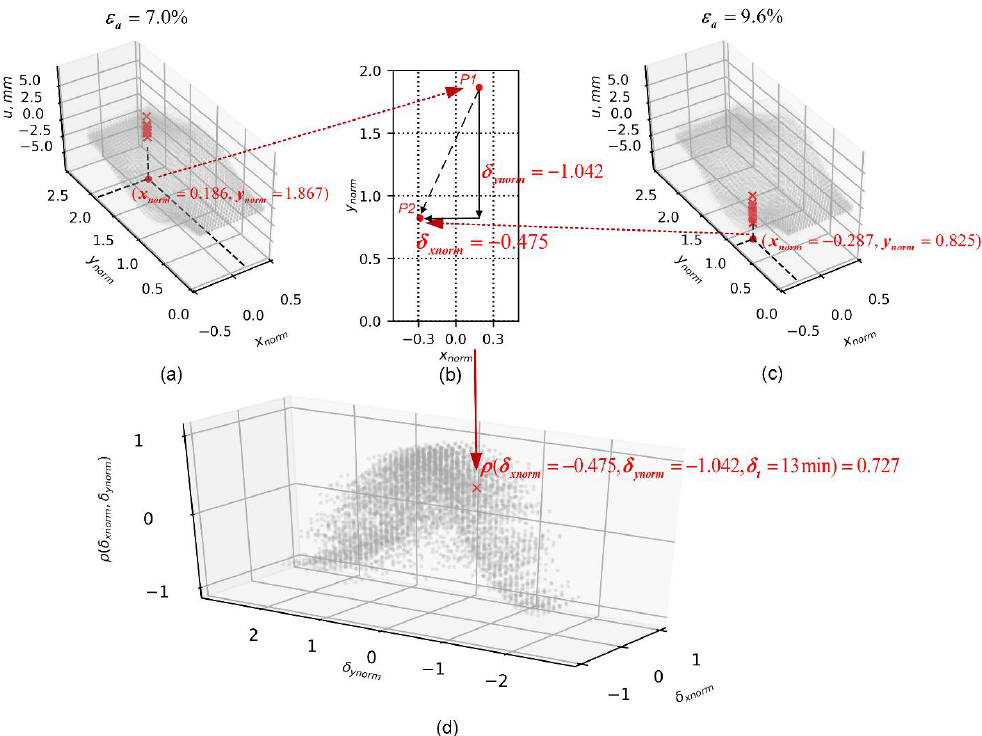
Figure 15. Computation of spatio-temporal correlation coefficients for 3D-T data ensembles. ( a ) Spatial coordinates of first displacement vector, u ( P 1 ) . ( b ) Spatial lags between u ( P 1 ) and u ( P 2 ) . ( c ) Spatial coordinates of second displacement vector, u ( P 2 ) . ( d ) Resultant correlation coefficient defined by spatio-temporal lags.